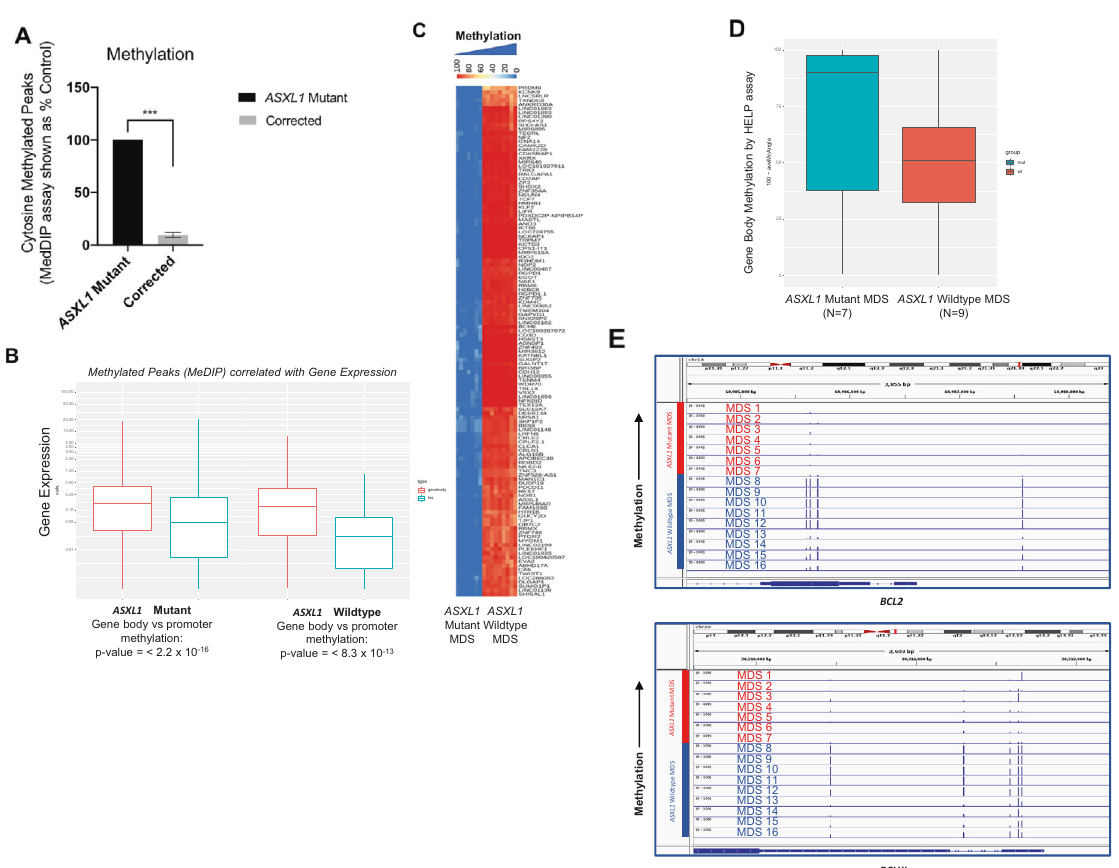
Fig. 4 ASXL1 mutation leads to aberrant genome methylation patterns. A Methylation DNA immunoprecipitation demonstrates widespread increased cytosine methylation in the ASXL1 mutant cells compared to the homozygous corrected cells. Analysis of this data shown as percent control demonstrates signi fi cantly more ( p -value = 0.0003, t test) cytosine methylation in the ASXL1 mutant cells compared to the corrected cells. B Evaluation of the methylation DNA immunoprecipitation data alongside the RNA sequencing data demonstrates a clear difference in expression between genes with methylation peaks in the gene bodies versus those with peaks in the gene promoter. Speci fi cally, increased methylation of the gene body was associated with increased gene expression, while increased methylation of the promoter region of genes was associated with decreased gene expression. C To validate the results in the primary samples, DNA methylation in a cohort of MDS ASXL1 mutant and wild-type peripheral blood mononuclear samples was assessed. The HELP assay revealed increased methylation in ASXL1 mutant samples particularly in the gene bodies, consistent with the results seen in the isogenic cell lines. D Genome- wide analysis of ASXL1 mutant and wild-type patient samples for gene body methylation demonstrate lower average methylation angles among the ASXL1 mutant samples ( n = 7) compared to the wild-type samples ( n = 9), indicating increased methylation in the gene body of the ASXL1 mutant patient samples, consistent with the results seen in the isogenic cell lines. E IGV plots for the BCL2 and BCLXL promoter regions of the ASXL1 mutant and wild-type patient samples demonstrate hypomethylation in the ASXL1 mutant samples (MDS 1 – 7, n = 7) compared to the wild type samples (MDS 8 – 16, n =